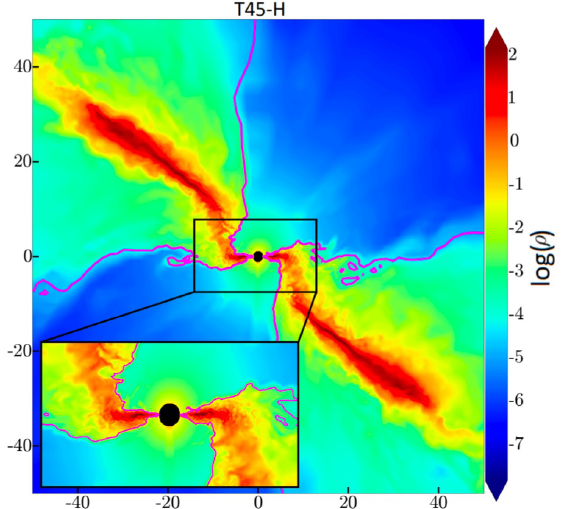
Figure 2. Snapshot of a vertical slice from a 3D GRMHD simulation of a tilted thin disk. The color contour shows logarithmic density. Magenta lines indicate the jet boundary, defined as p b = 5 ρ c 2 . The results present the alignment of the inner disk along the equator. Figure is reproduced with permission from Liska et al. MNRAS, 507, 983 (2021)